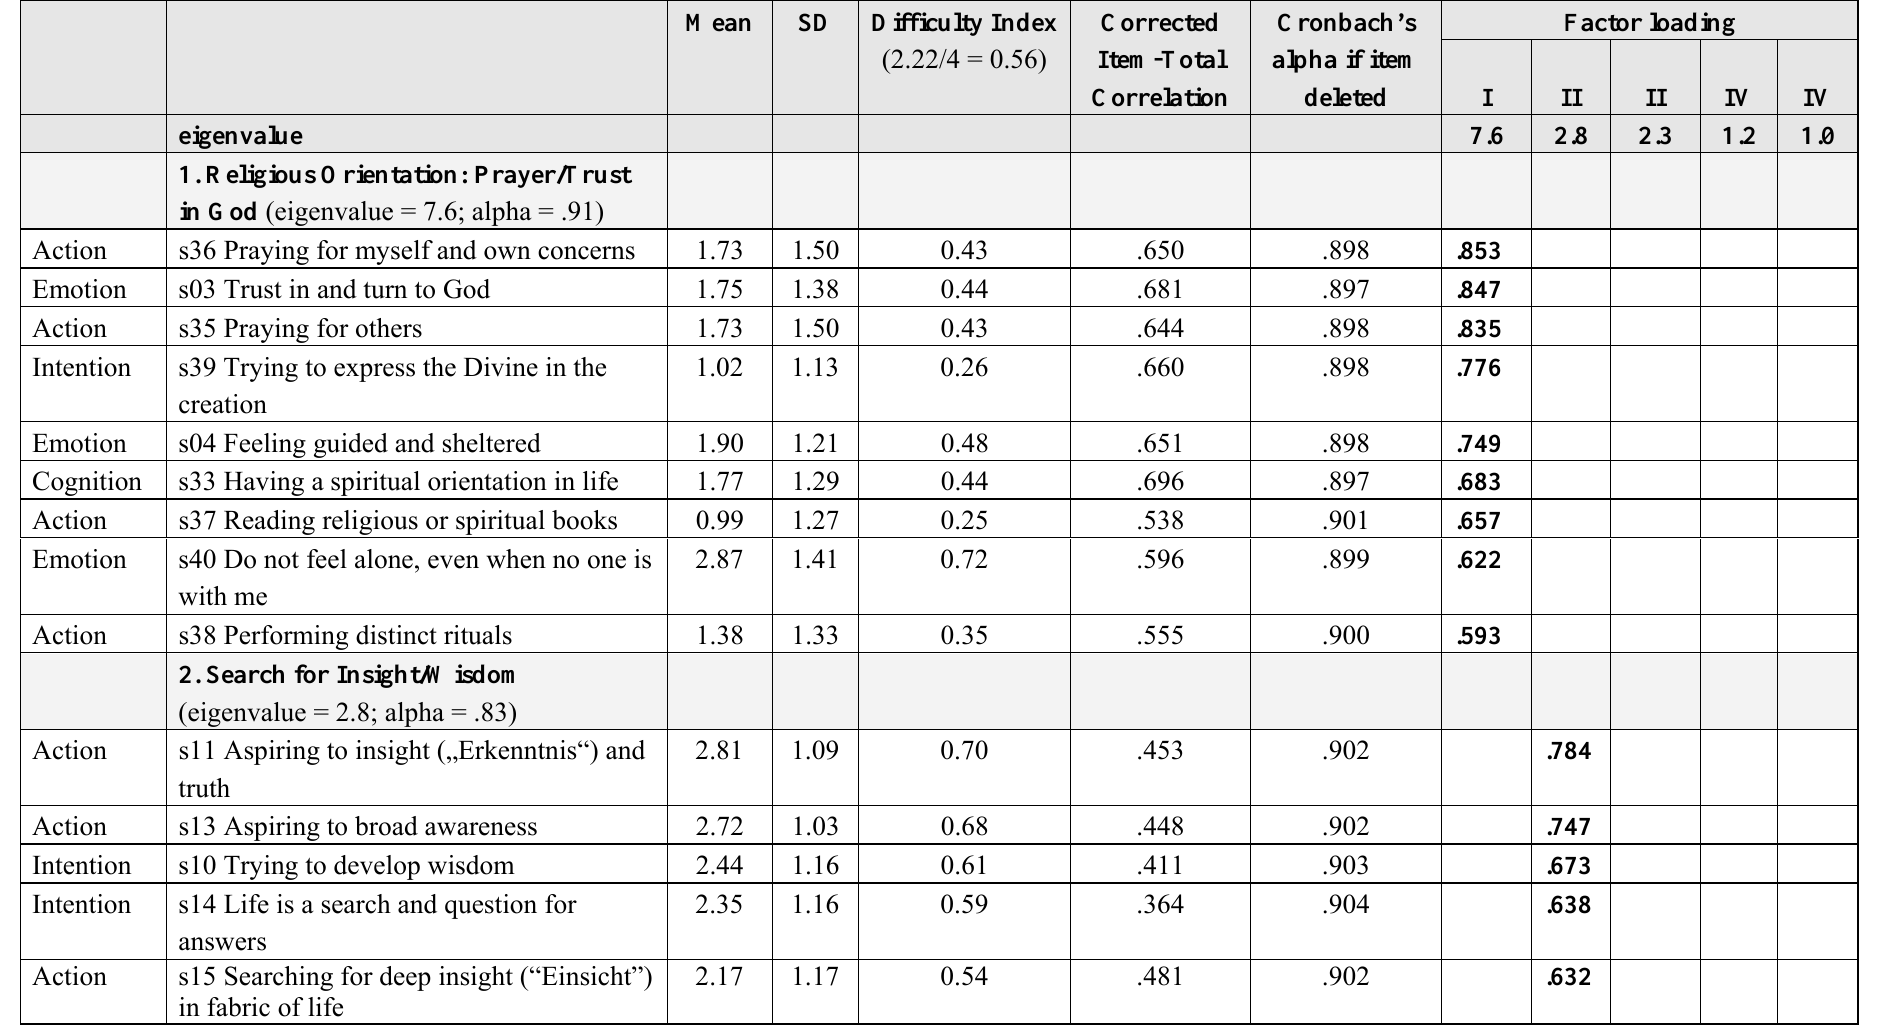
Table 2. Factors of the ASP questionnaire Version 2.2 (25 items)—German